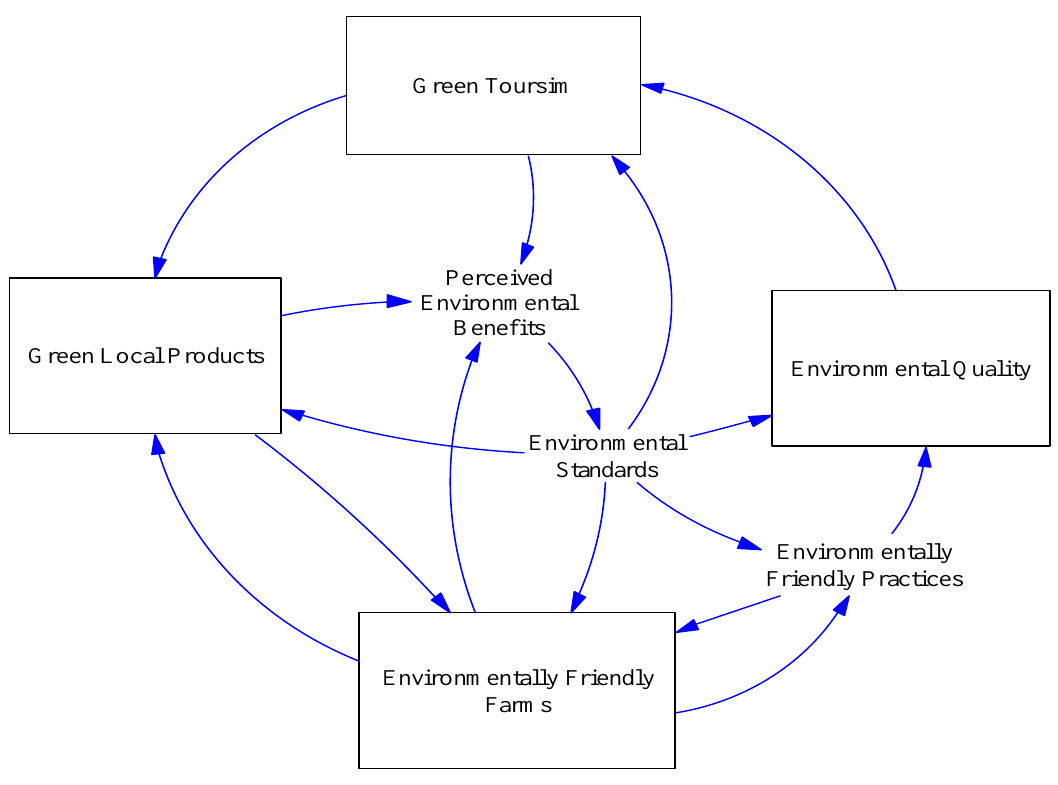
Figure 3: Regional sustainability model with four main parts